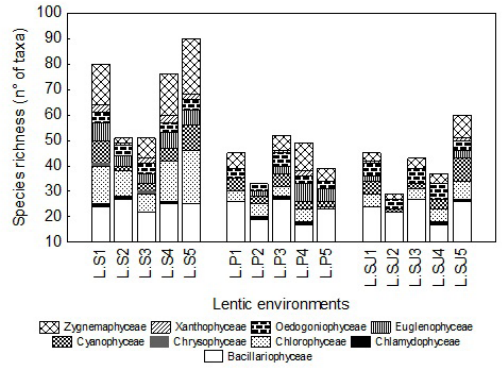
Figure 4. Spatial variation in species richness by classes in the sampling sites of the Upper Paraná River floodplain.